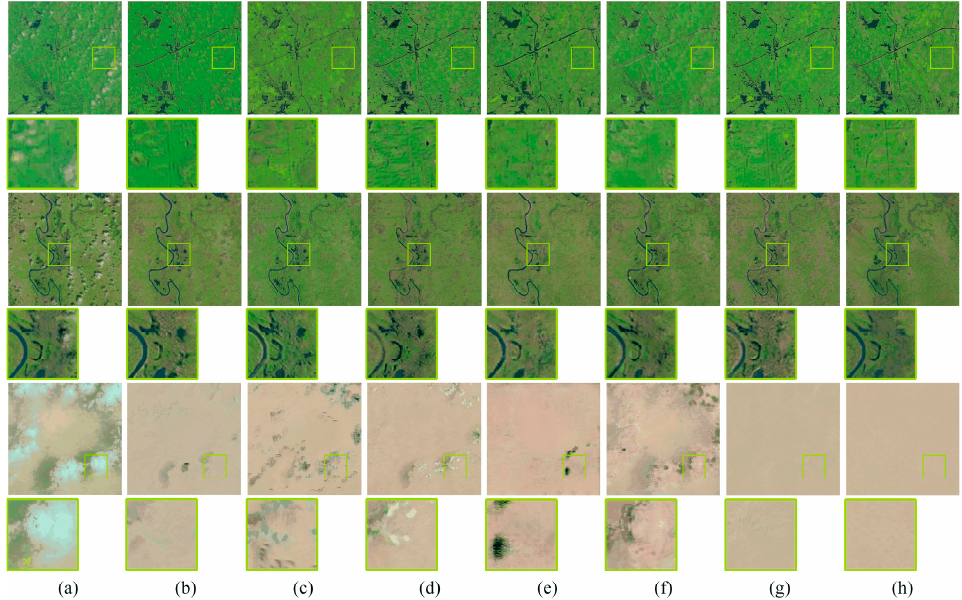
Figure 7. Results of each method for RICE2. ( a ) Cloudy images; ( b ) Cloud-GAN; ( c ) cGAN; ( d ) SpA-